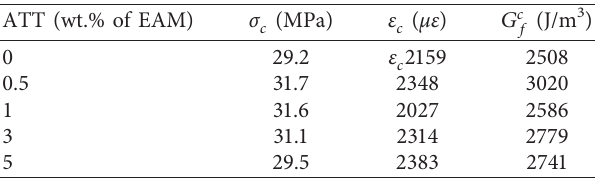
Note: σ c � critical stress; ε c � critical